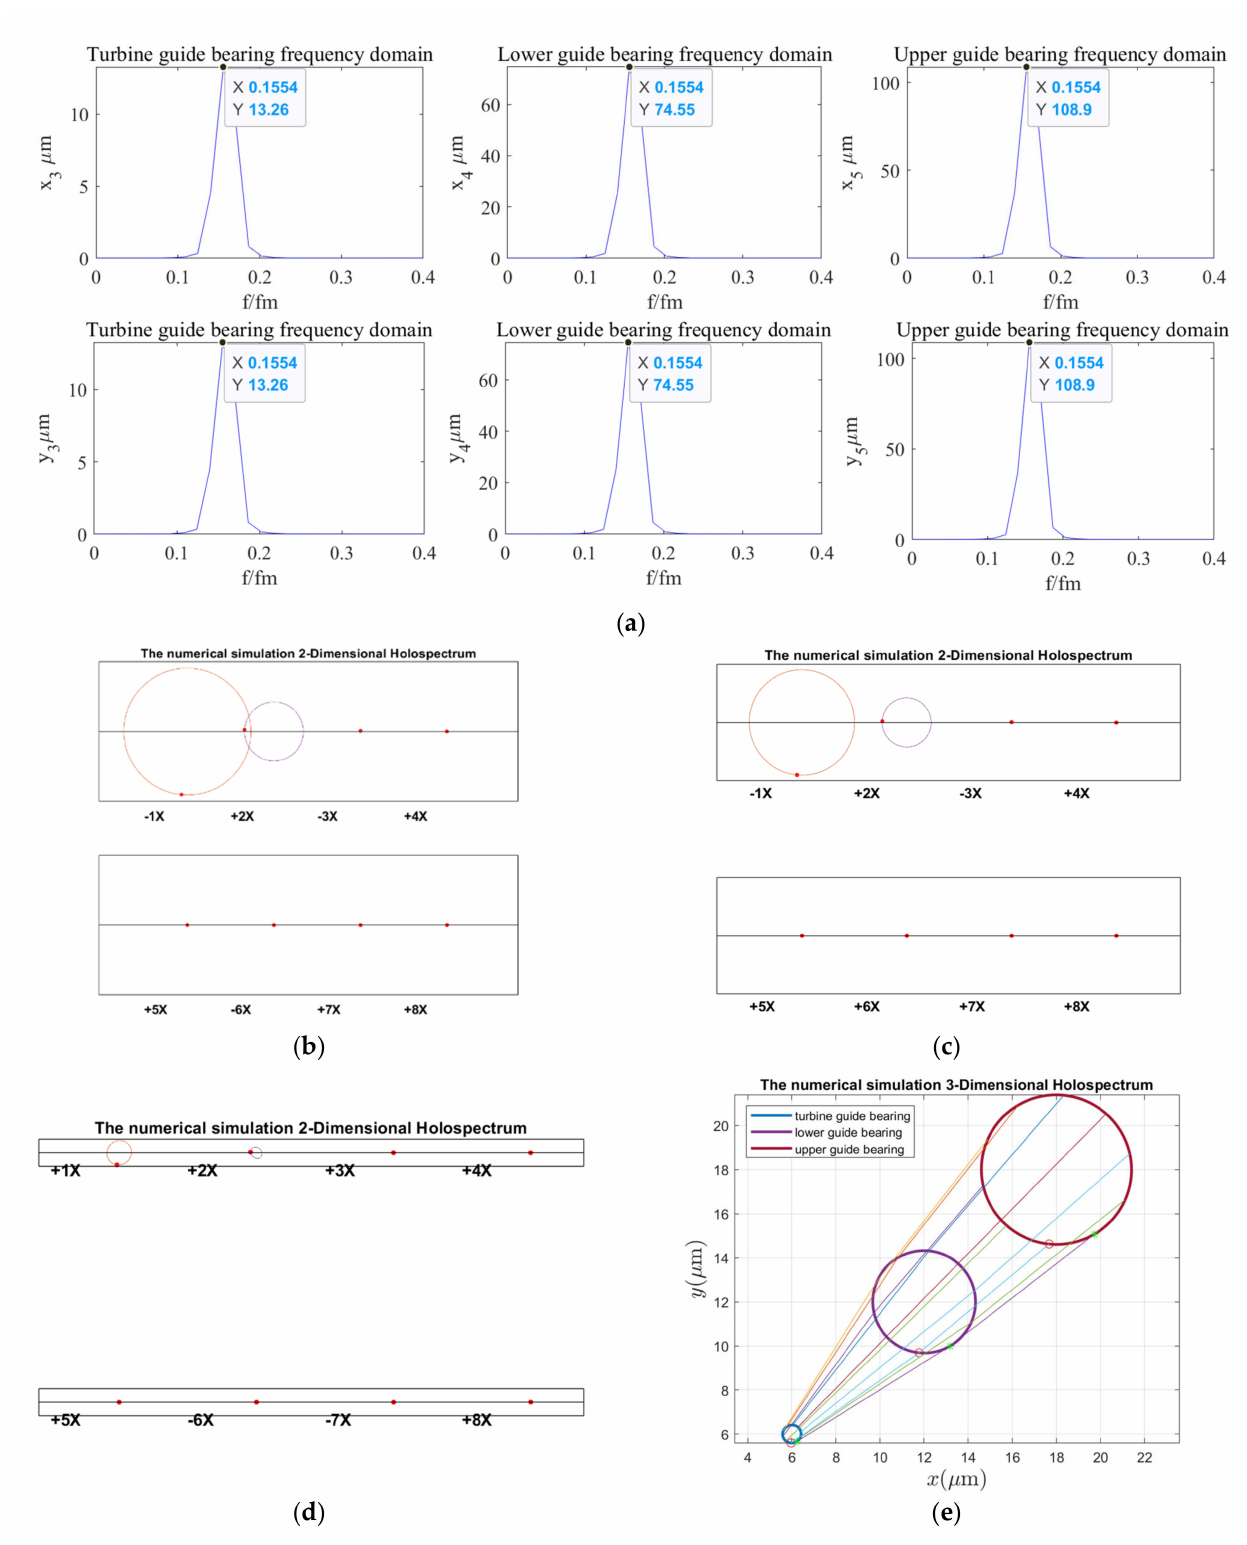
Figure 14. Holospectrum of shafting vibration of misaligned unbalance rotor, considering the oil film force: ( a ) Shafting vibration spectrogram, ( b ) Upper guide bearing 2D holospectrum, ( c ) Lower guide bearing 2D holospectrum, ( d ) Hydro-turbine guide bearing 2D holospectrum, ( e ) One-fold frequency 3D